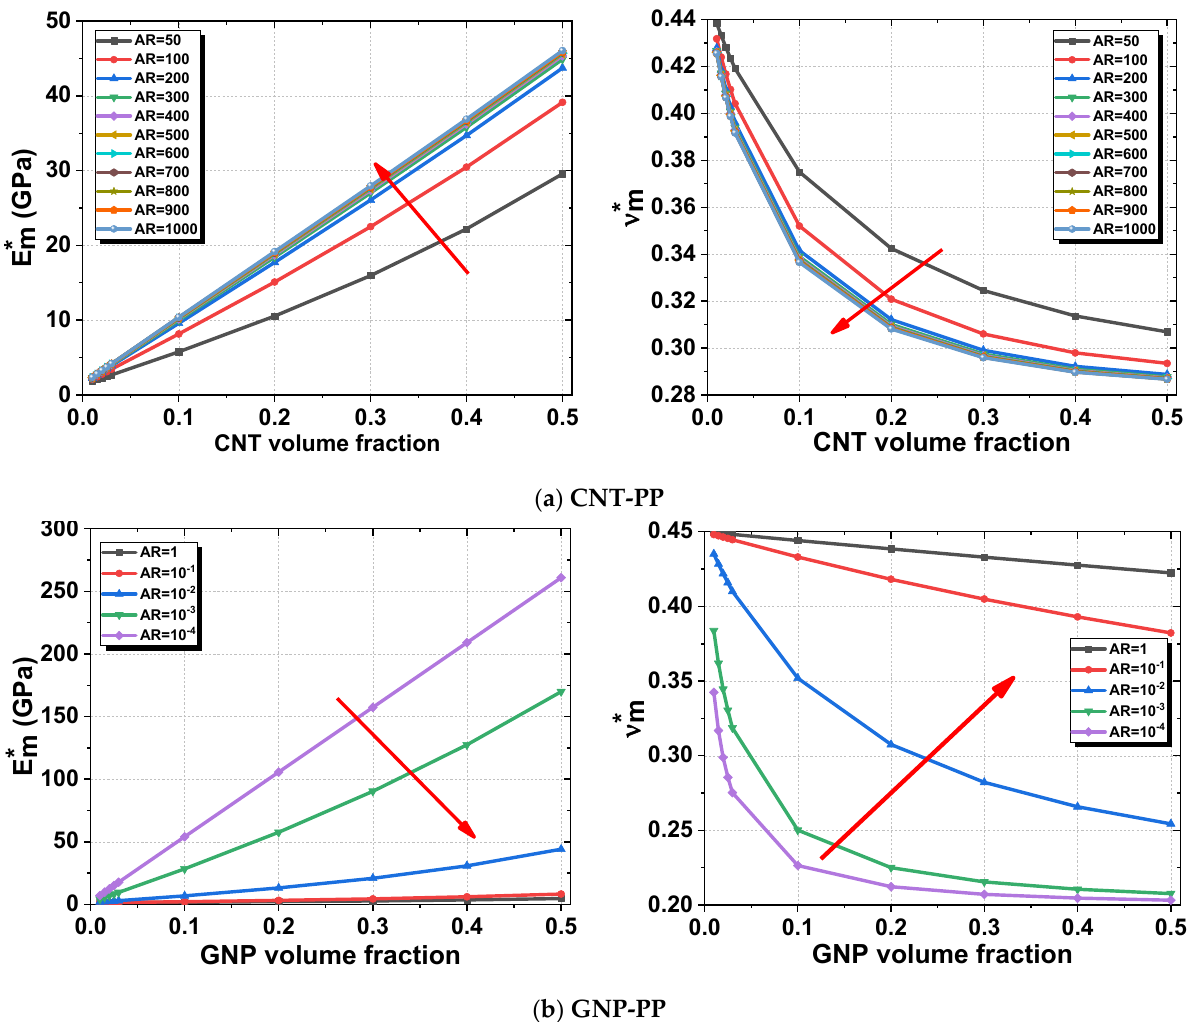
Figure 9. Effect of the aspect ratio of randomly oriented CNT/GNP inclusions on the elastic properties of the composite. ( a ) CNT reinforced PP. ( b ) GNP reinforced PP.